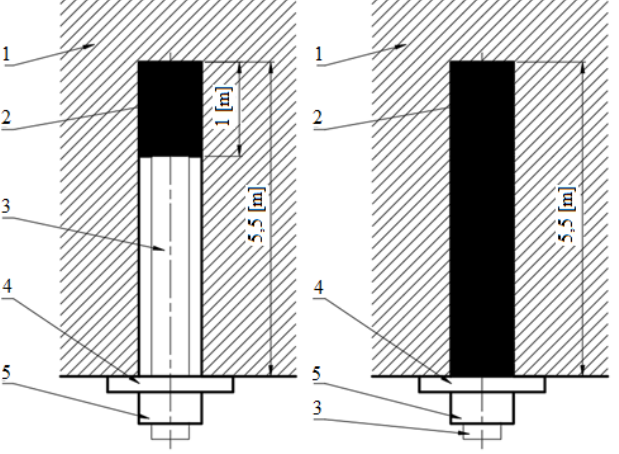
Figure 9. Anchor fixing scheme: 1—rock; 2—glue; 3—anchor bolt; 4—washer; 5—nut. The tested anchors were labeled K1 through K5 for easier identification of the mea- surements. The anchors were spaced differently. A schematic of the anchor placement in the Klein II transverse and in the Vernier longitudinal is shown in Figure